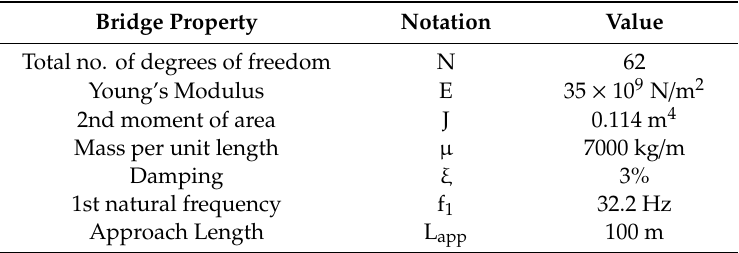
Table 1. Properties of the